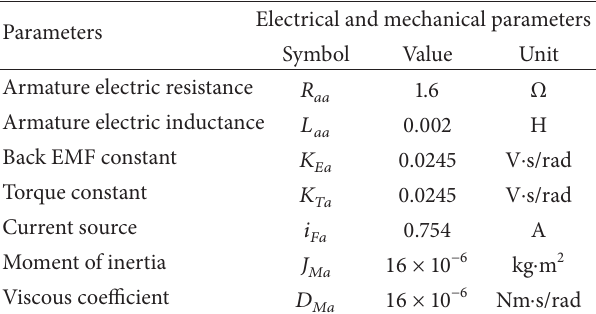
Table 3: Azimuth motor